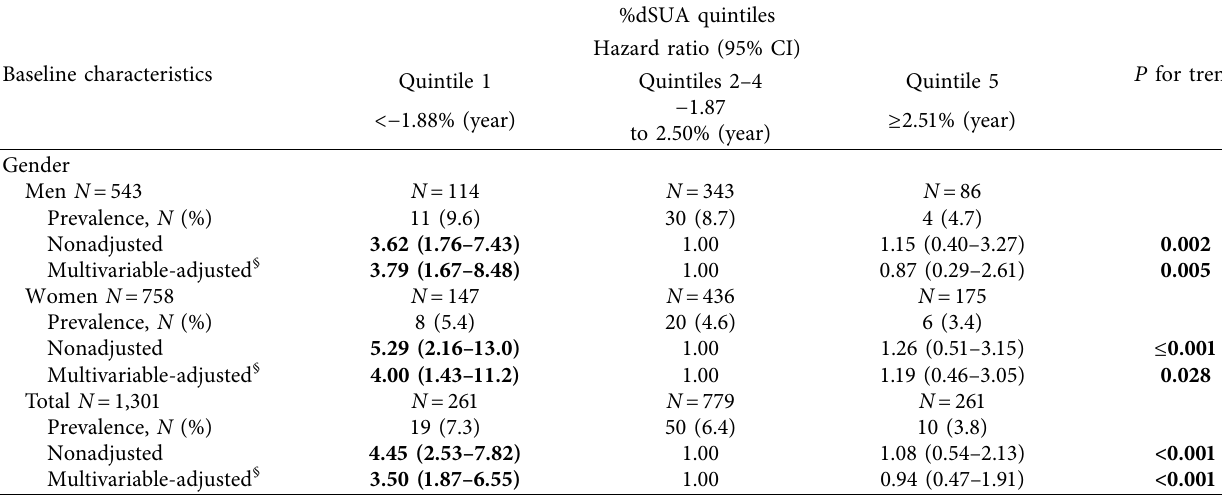
Table 2: Hazard ratios and 95% CIs for all-cause mortality according to %dSUA quintiles stratifed by gender.